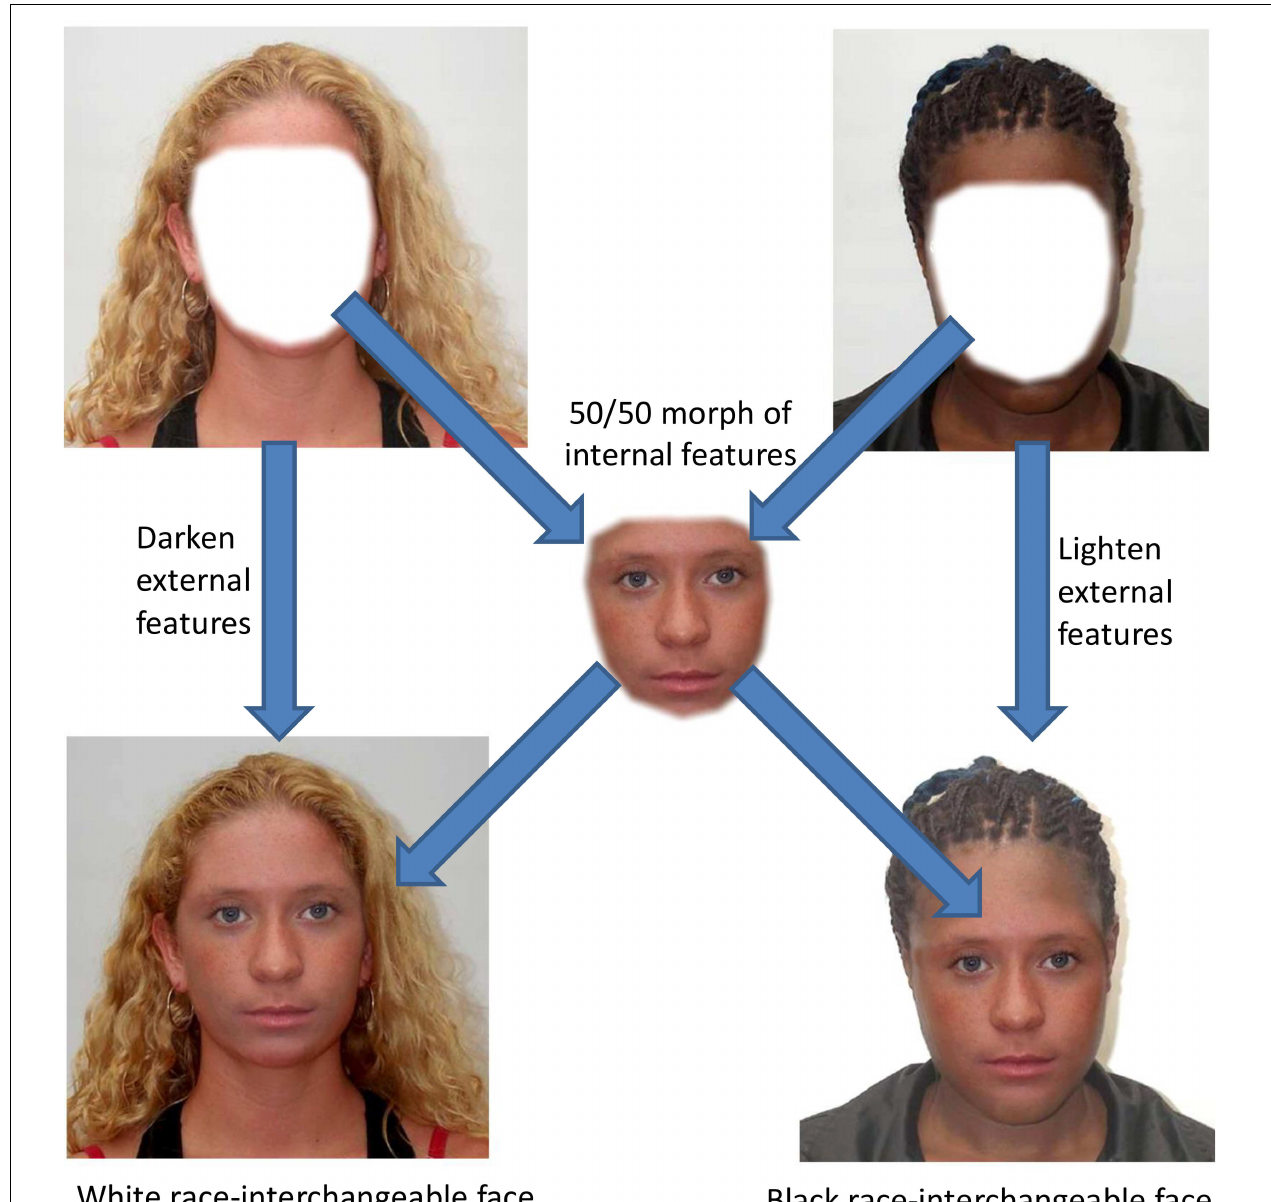
FIGURE 1 | Construction of the race-interchangeable faces. A White and a Black parent faces are morphed to produce a blended image of the internal features. These internal features are inserted back into the parent faces whose external features have been either lightened or darkened so that the skin lightness matches the